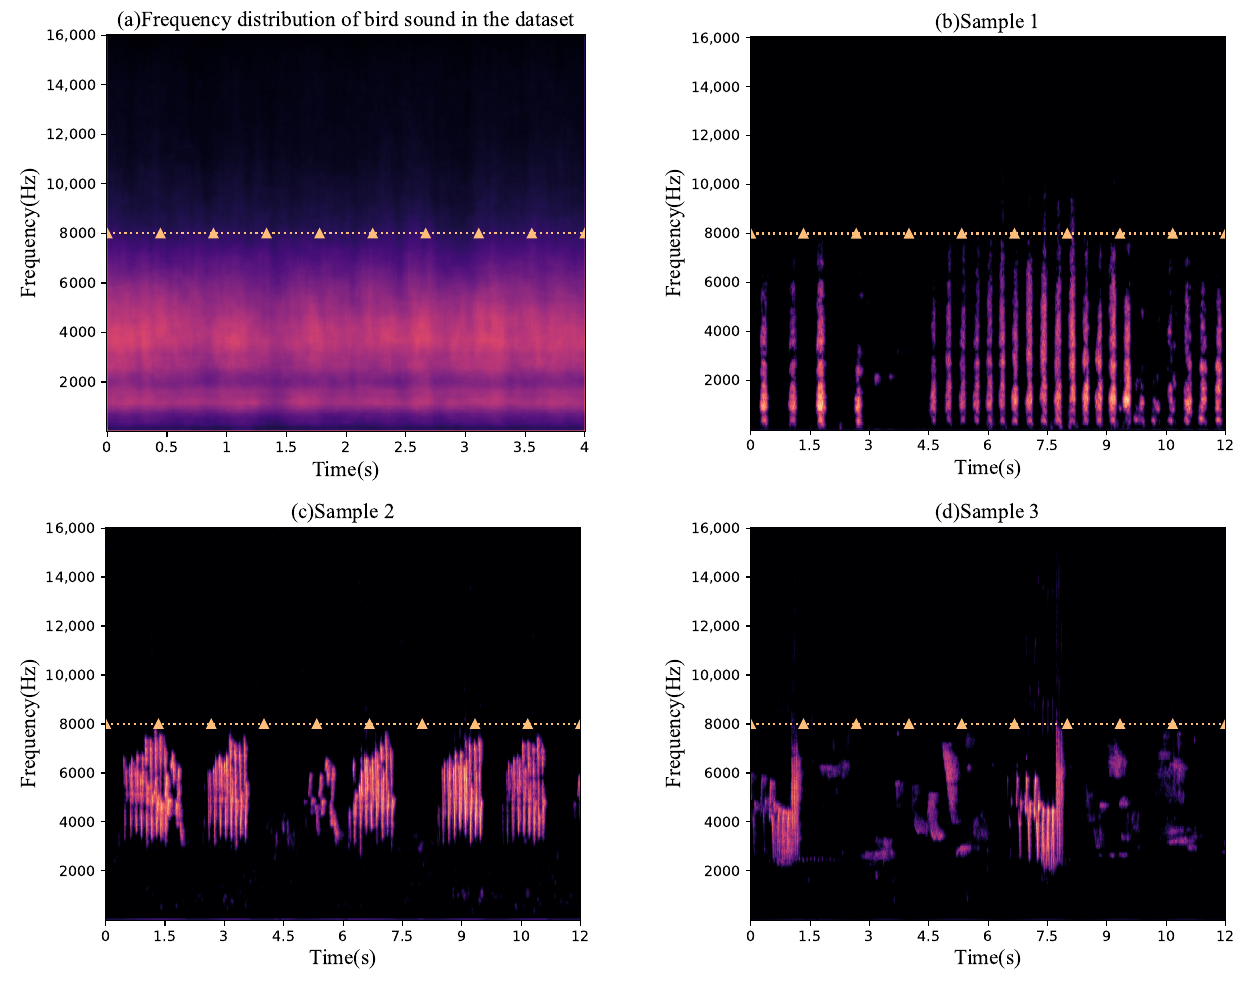
Figure 2. Frequency distribution of bird sounds in the dataset and some